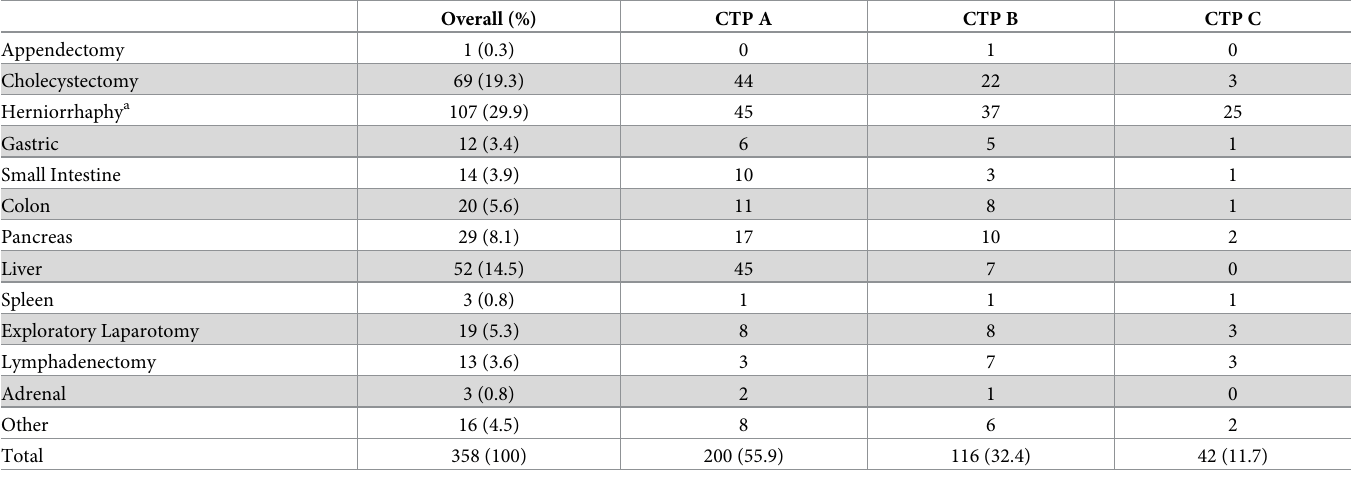
Table 2. Operations